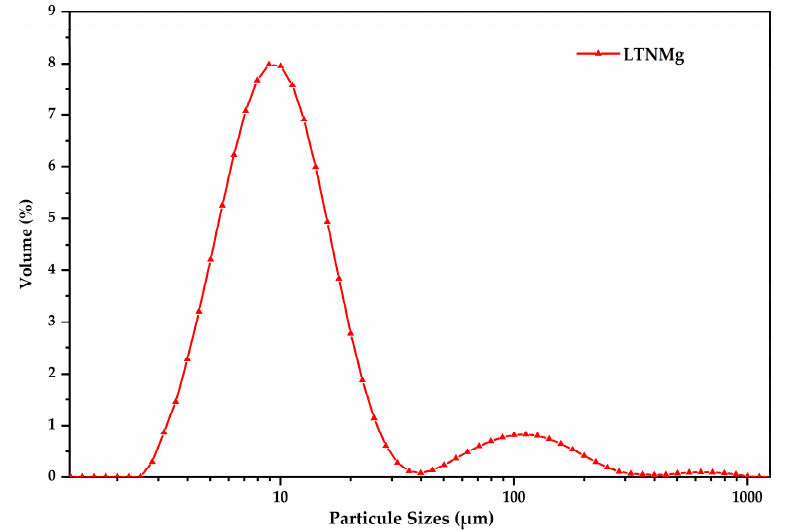
Figure 4. Particle size distribution of the synthesized Li 0.95 Ta 0.76 Nb 0.19 Mg 0.15 O 3 phase.